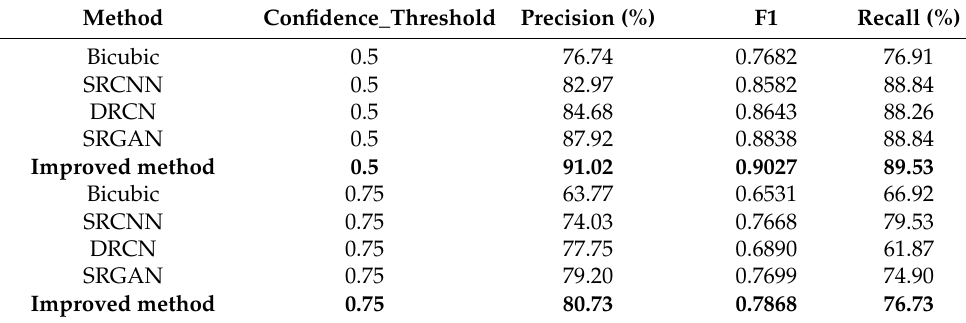
Table 5. Self-built dataset pavement crack detection